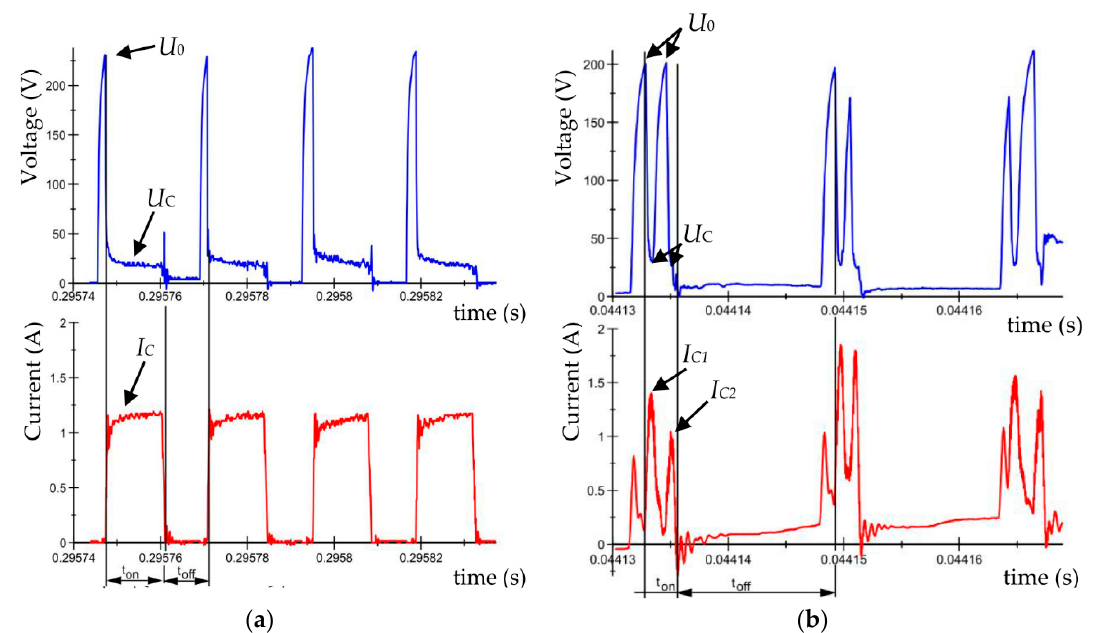
Figure 3. Recorded voltage and current waveforms: EDM fluid dielectric ( a ) U 0 = 225 V, U = 25 V, I = 1.2 A, t on =10 µs, t off = 8 µs, pure dielectric; and ( b ) U 0 = 200 V, U C = 25 V, I = 1.5 A, t on = 3 µs, t off = 13 µs, I = 1.2 A, t on =10 µ s, t off = 8 µ s, pure dielectric; and ( b ) U 0 = 200 V, U C = 25 V, I = 1.5 A, t on = 3 µ s, EDM fluid with 0.1% RGO. t off = 13 µ s, EDM fluid with 0.1%